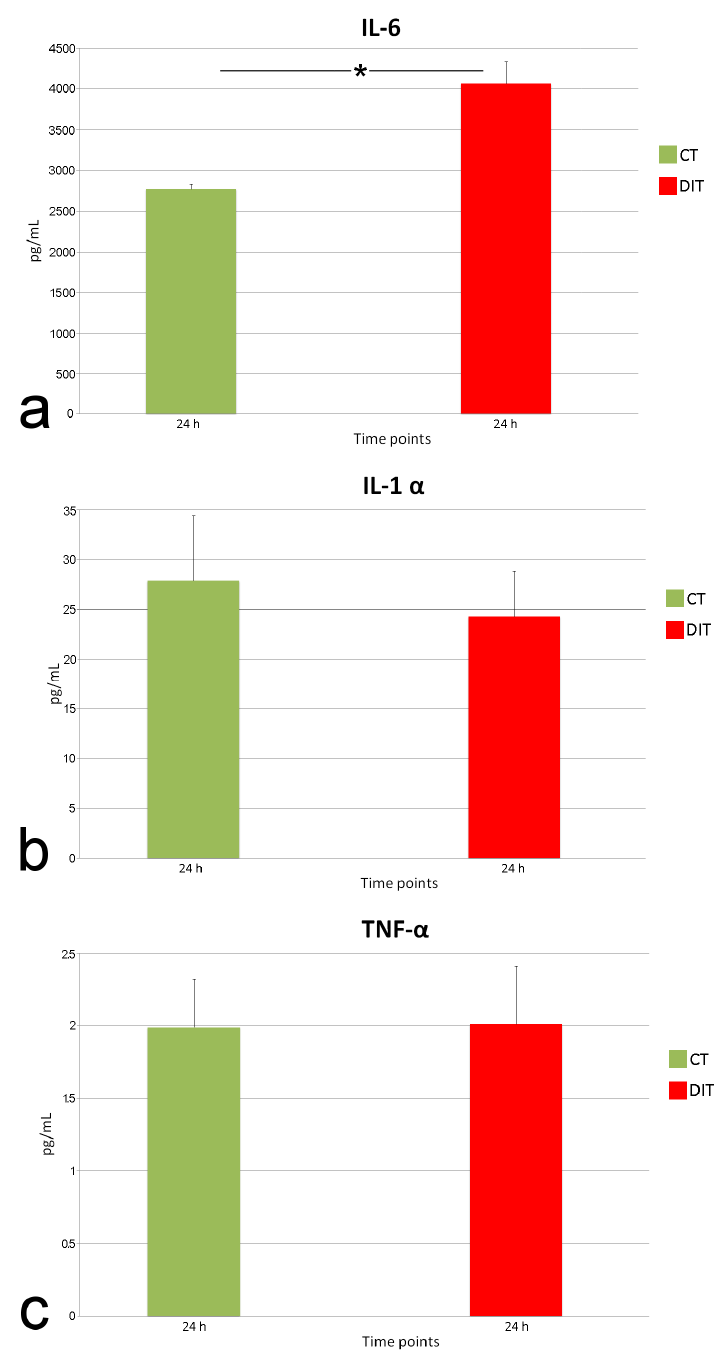
Figure 9. ( a ) Mean ± standard error values of IL-6 in culture medium of samples treated with dithranol. Asterisk indicates signi fi cant di ff erence ( p = 0.028). ( b ) Mean ± standard error values of IL-1alpha in culture medium of samples treated with dithranol. No signi fi cant di ff erence was